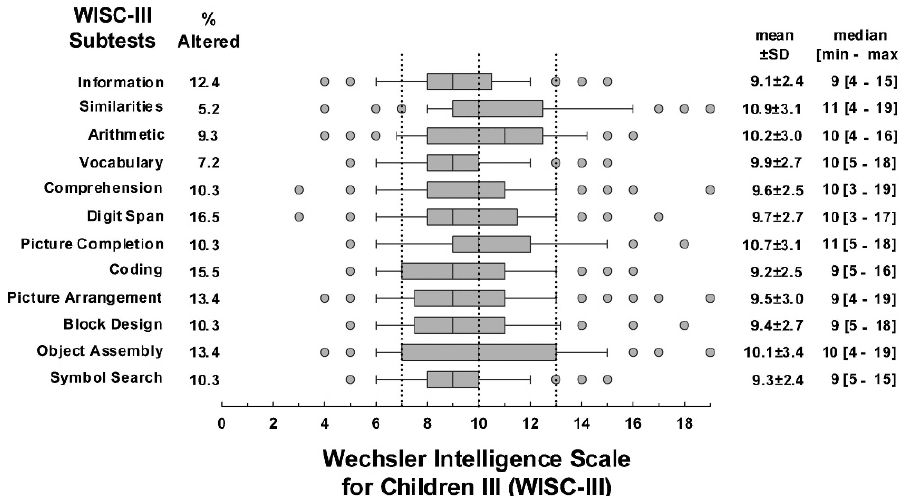
Figure 1 - Boxplot graphic for scores on the WISC-III subtests obtained in the study sample. The first six subtests comprise the verbal IQ, and the others comprise the executive IQ The data are presented as the mean ¡ standard deviation (SD), median, minimum (min), maximum (max) and percentage of observations below the cut-off point 7 (minimum value for